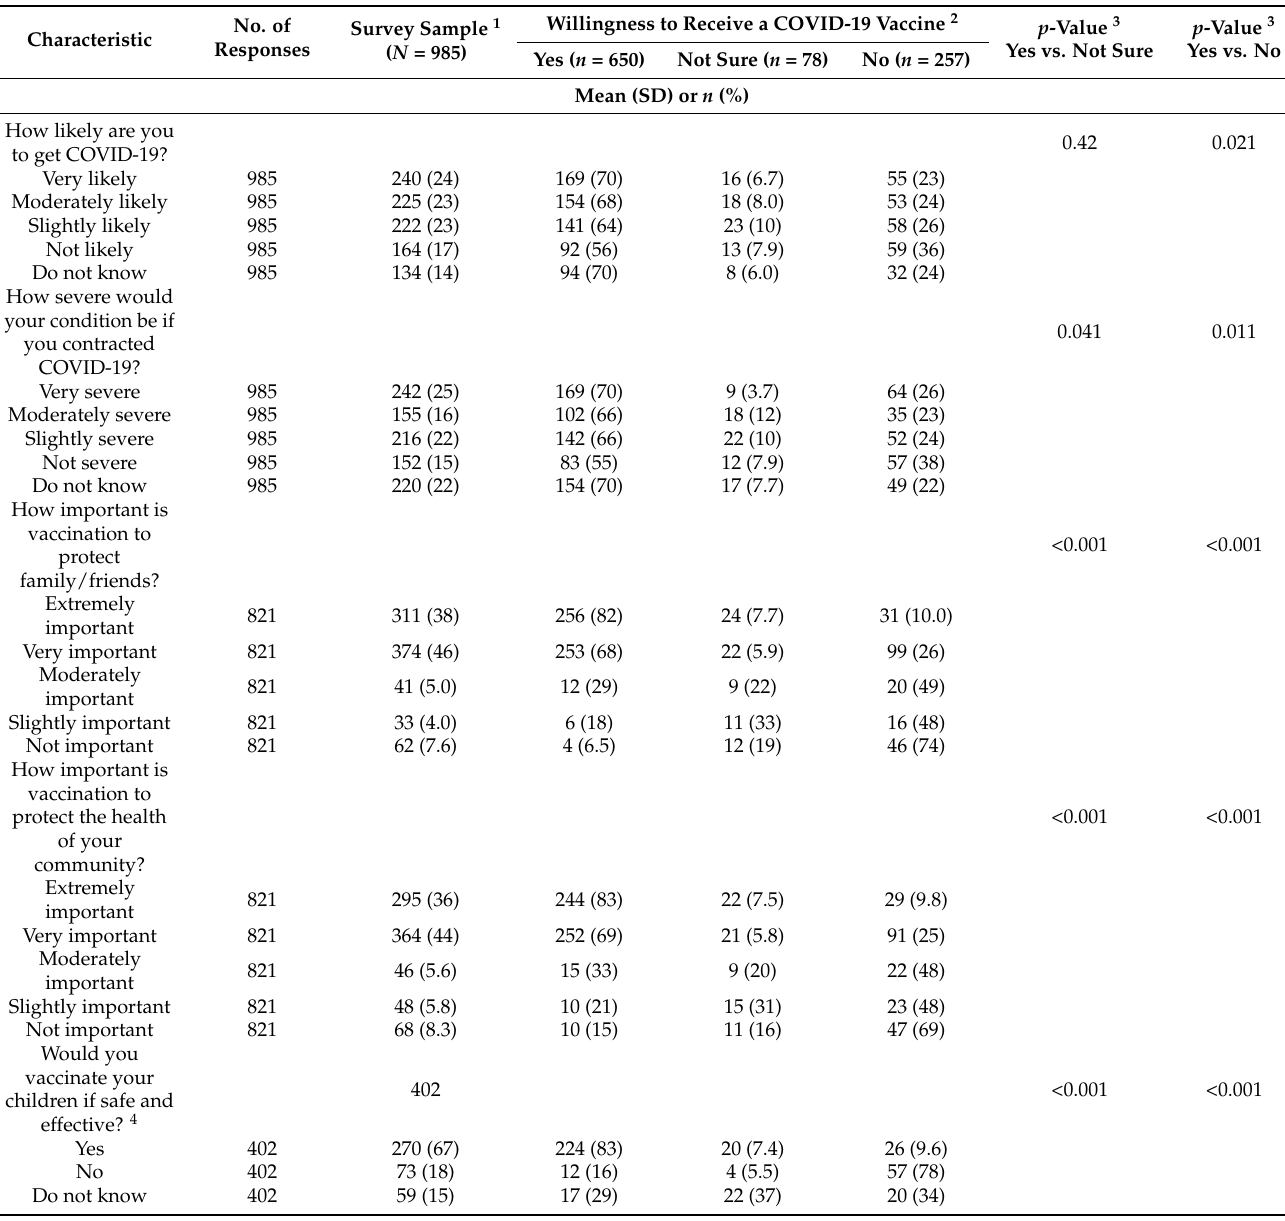
Table 2. Attitudes related to COVID-19 risk and vaccination among Pau da Lima residents and the willingness to receive COVID-19